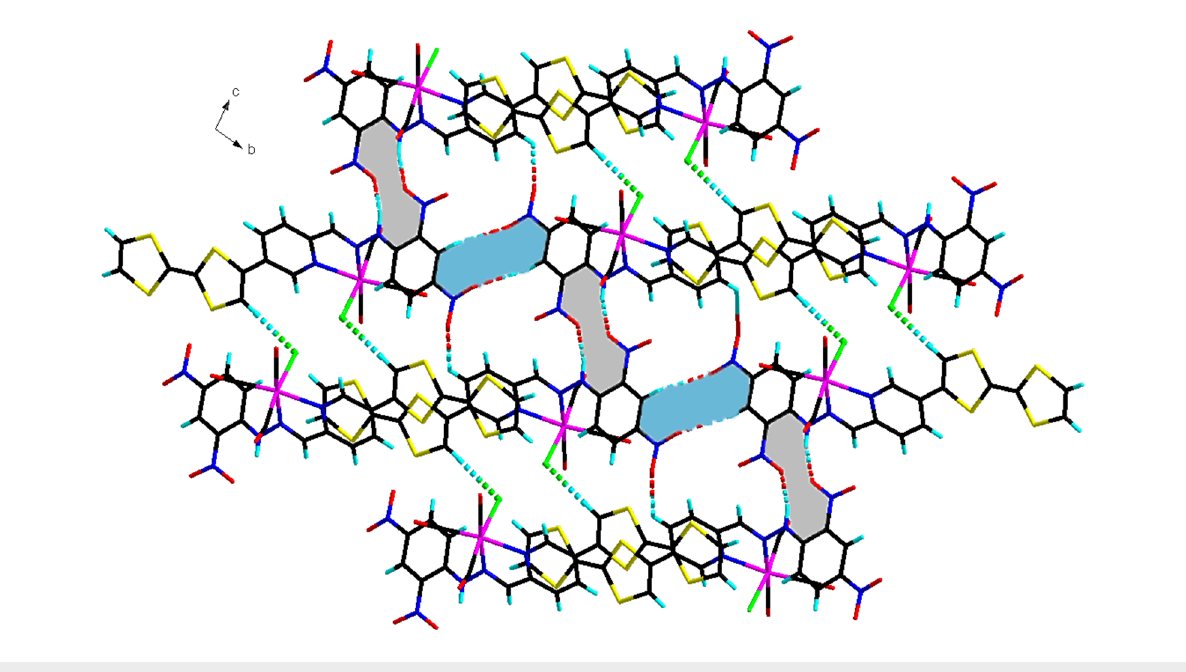
Figure 11: Layered structure of complex 3 viewed along the a -axis. The dimers are linked together through hydrogen bonding that form R 22 (10) in blue filling and R 22 (12) in grey filling cyclic motifs.